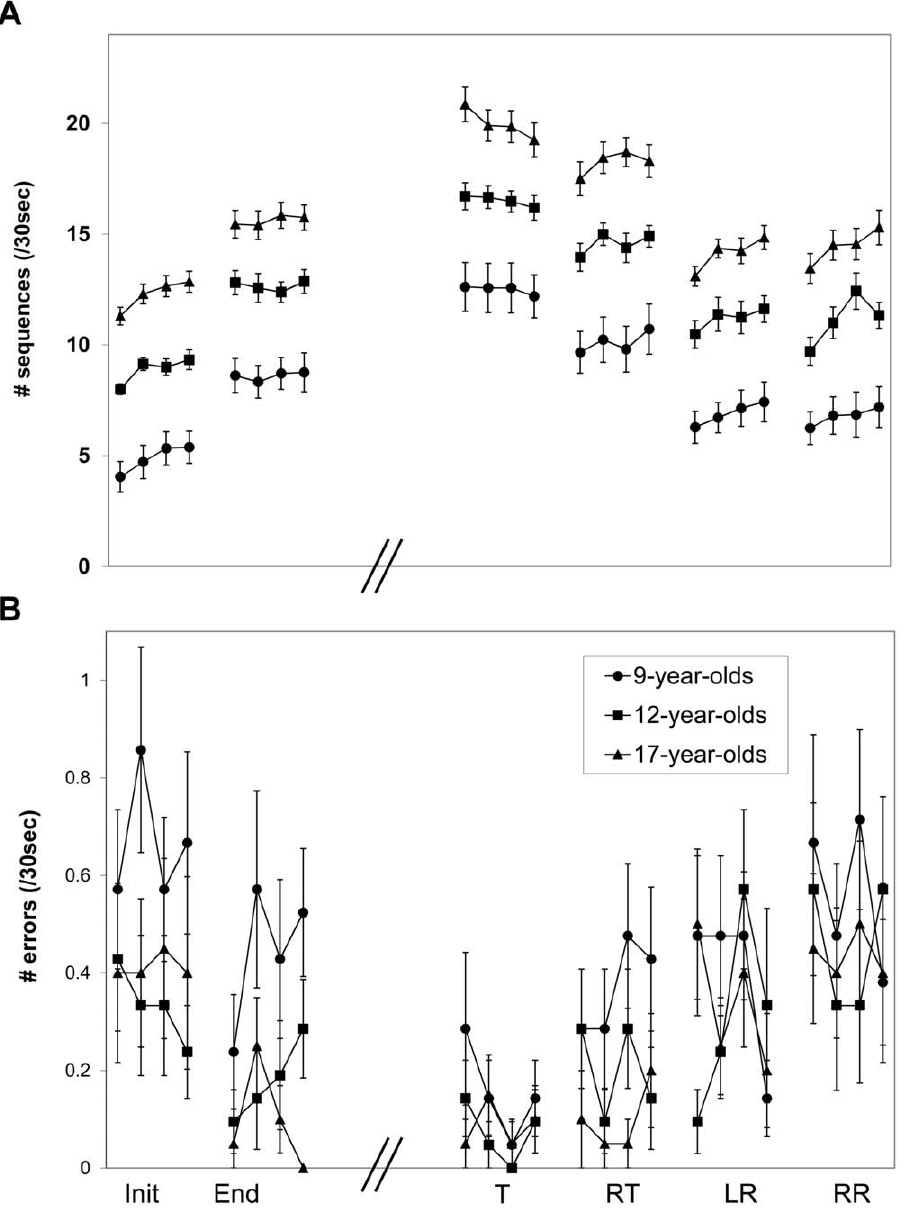
Figure 2. Retention and transfer after a single training session. Shown is performance on the trained and transfer conditions at 48 hours post-training (T, trained; LR, left reversed; RR, right reversed; RT, right trained). Bars –Standard Error.